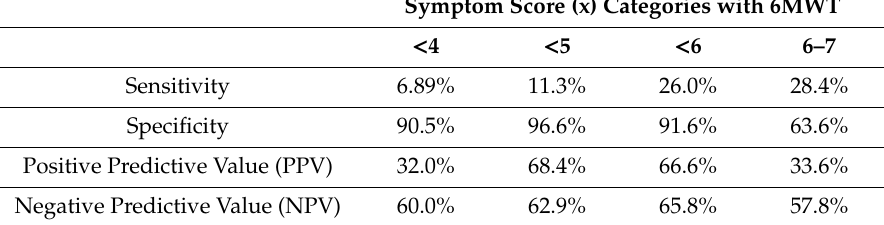
Table 1. Specificity of diagnosing critical limb ischemia using six-minute walk distance and symptoms score alone.